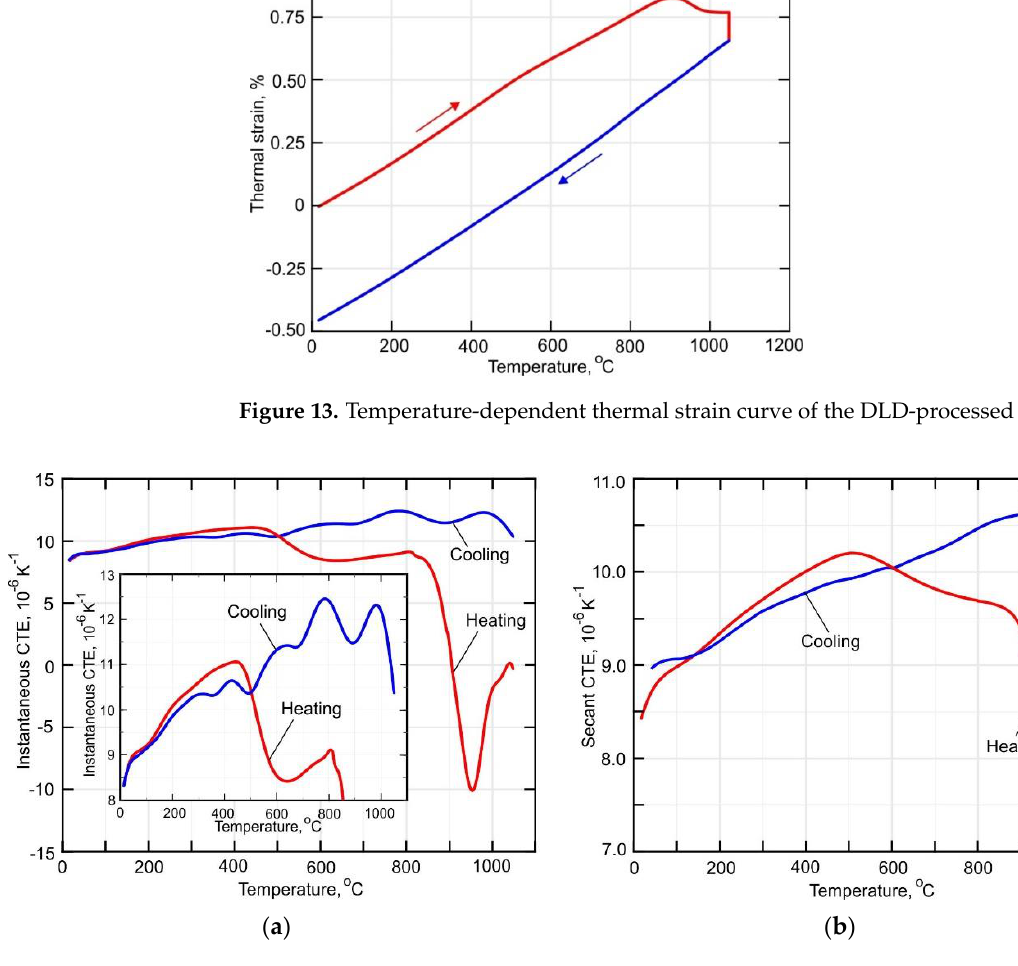
Figure 14. Temperature dependent coefficient of thermal expansion of ( a ) an instantaneous and ( b ) secant.